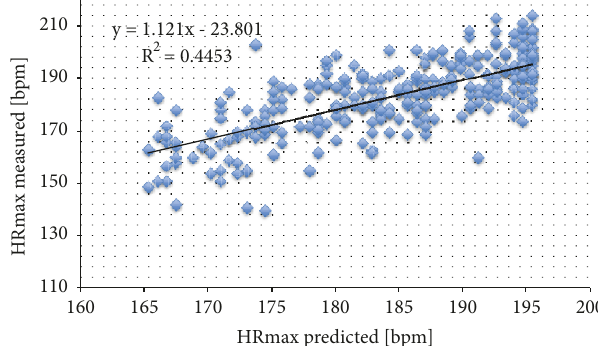
Figure 1: Scatterplot illustrating the correlation between HR max measured during the 20-meter shuttle run test (Y-axis) and HR max predicted using the formula of Tanaka et al. [20] (x-axis). HR max : maximal heart rate.